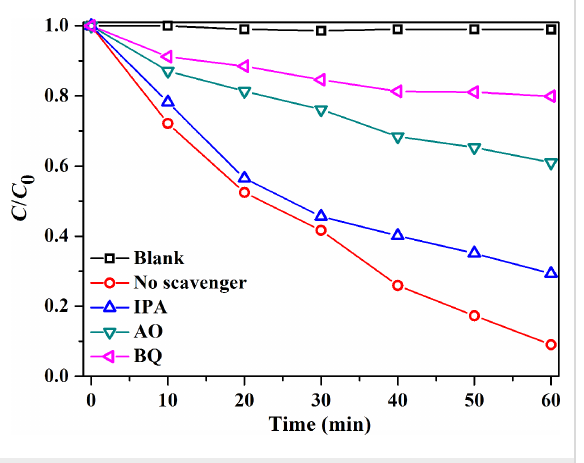
Figure 9: Active-species trapping tests over 0.3AgI/Ag 2 WO 4 .